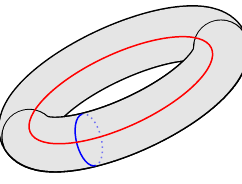
Figure 1 . Labels of vertices for a face f lying in the plane spanned by directions i, j .